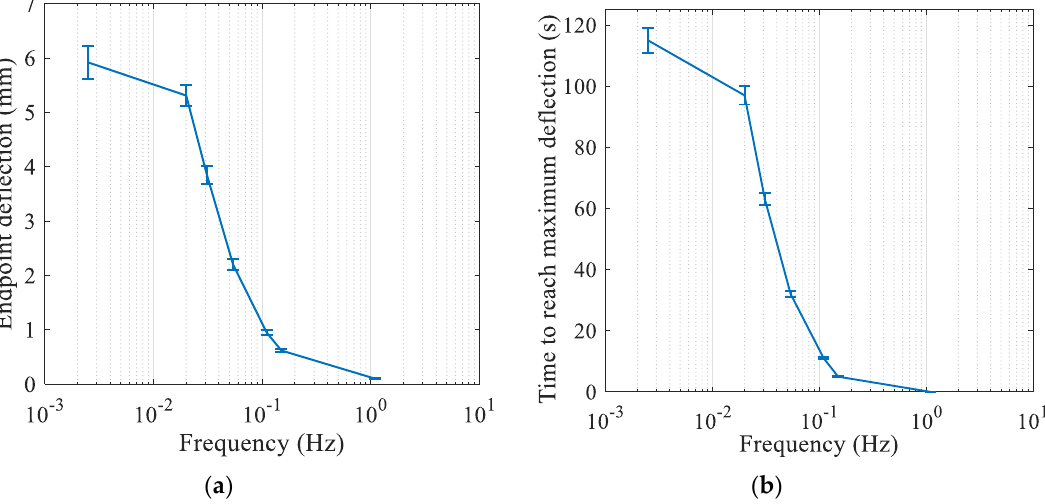
Figure 6. ( a ) Response of actuator’s maximum endpoint deflection to various frequencies under 5 V square waves. ( b ) Response time to first peak. Error bars indicate the standard deviation of the maximum distance measured over the three trials.